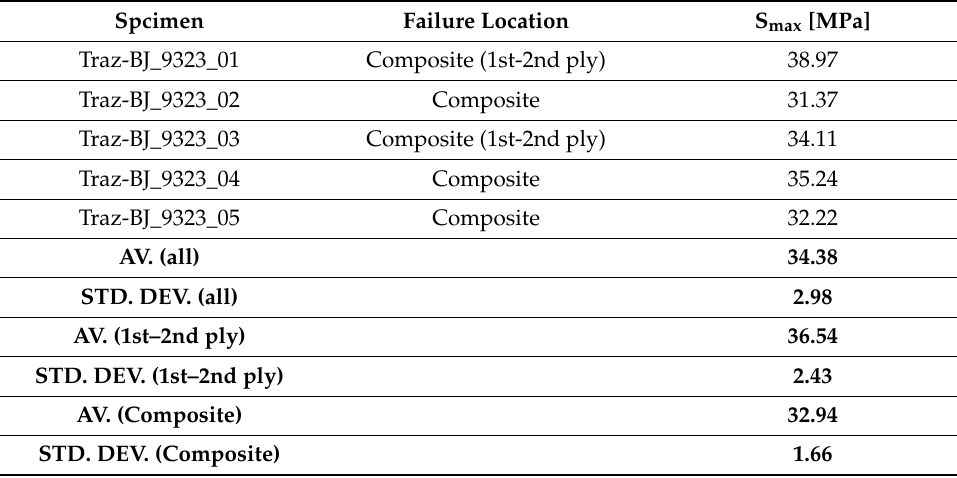
Table 6. Failure location and tensile strength of TRAZ-BJ_9323